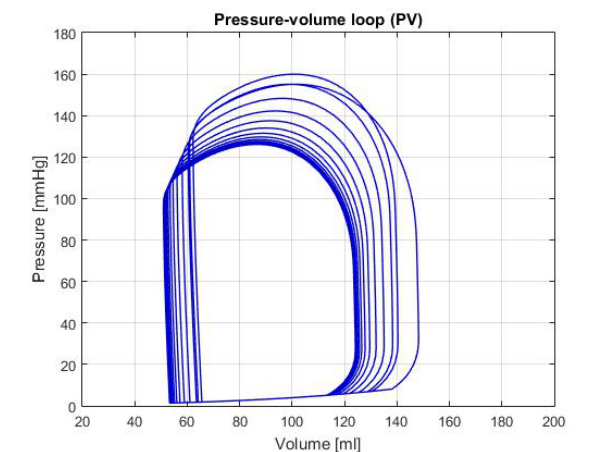
Figure 7. Graph of P-V loop curves with Right Ventricle Heart Failure